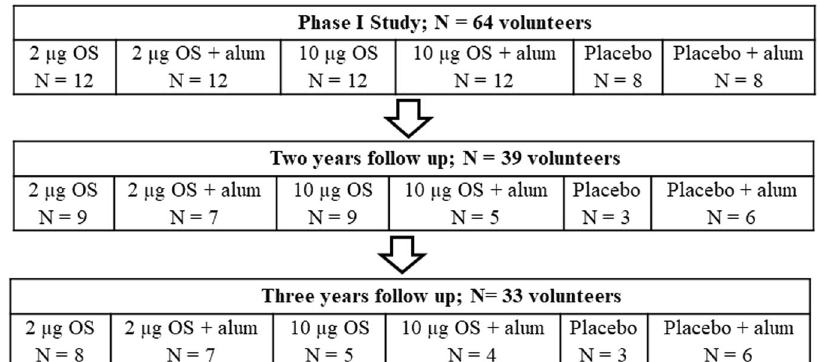
Fig. 5 Upper panel (phase I study), middle panel (at 2-year follow-up) and lower panel (at 3-year follow-up). Distribution of volunteers in the long-term follow up according to the randomized allocation in the phase I